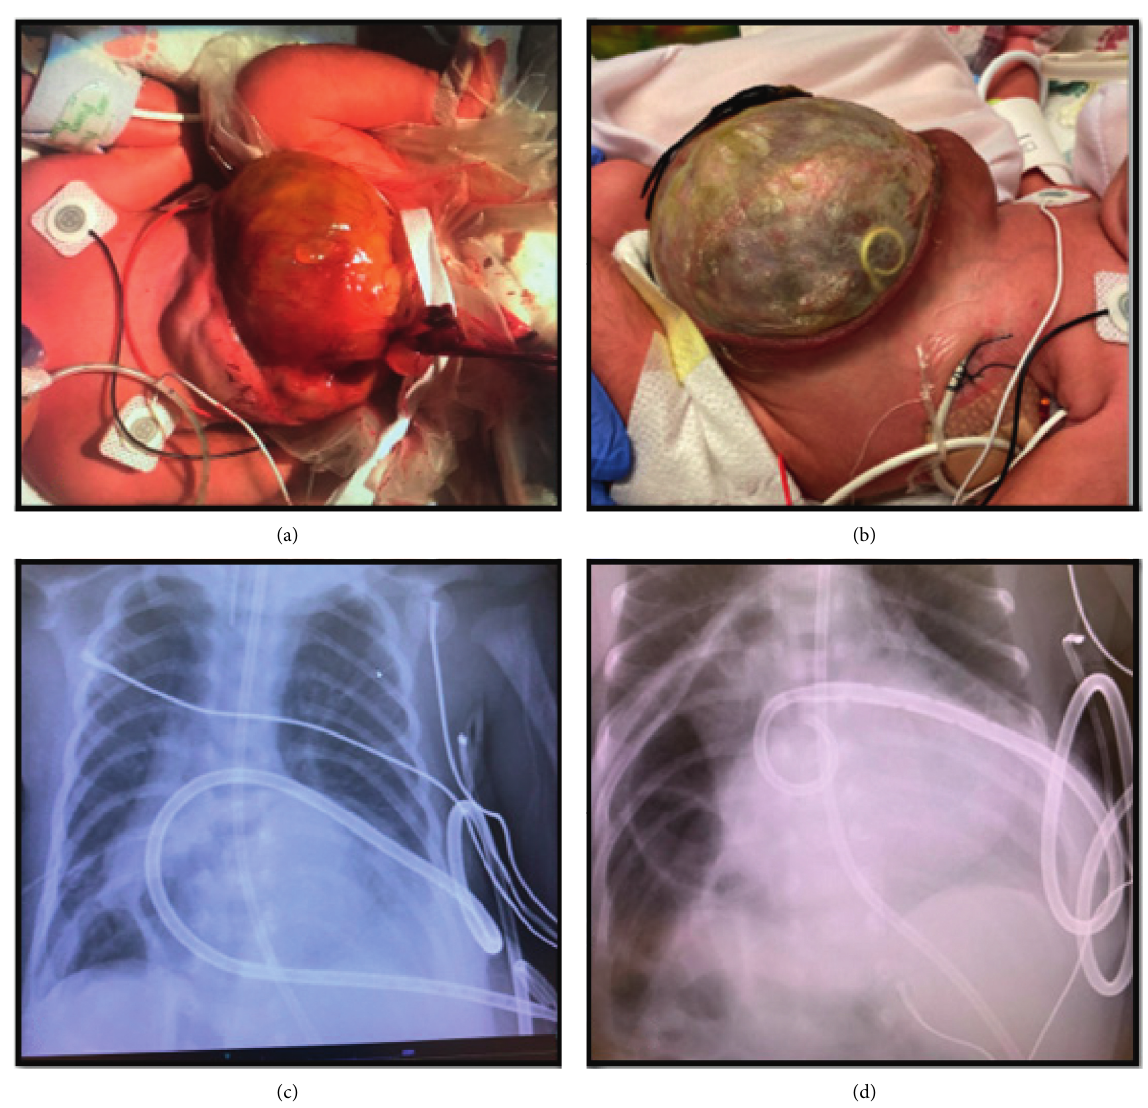
Figure 2: Omphalocele and drain images: (a) the patient’s omphalocele at birth. (b) The Pigtail catheter placed in the pericardium is seen in the omphalocele sac, demonstrating continuity of the pericardium with the abdominal cavity. (c) Pericardial drain is seen in chest X-ray coursing around the cardiac silhouette and into the omphalocele. (d) The pigtail is retracted 2cm with adequate draining and outside the